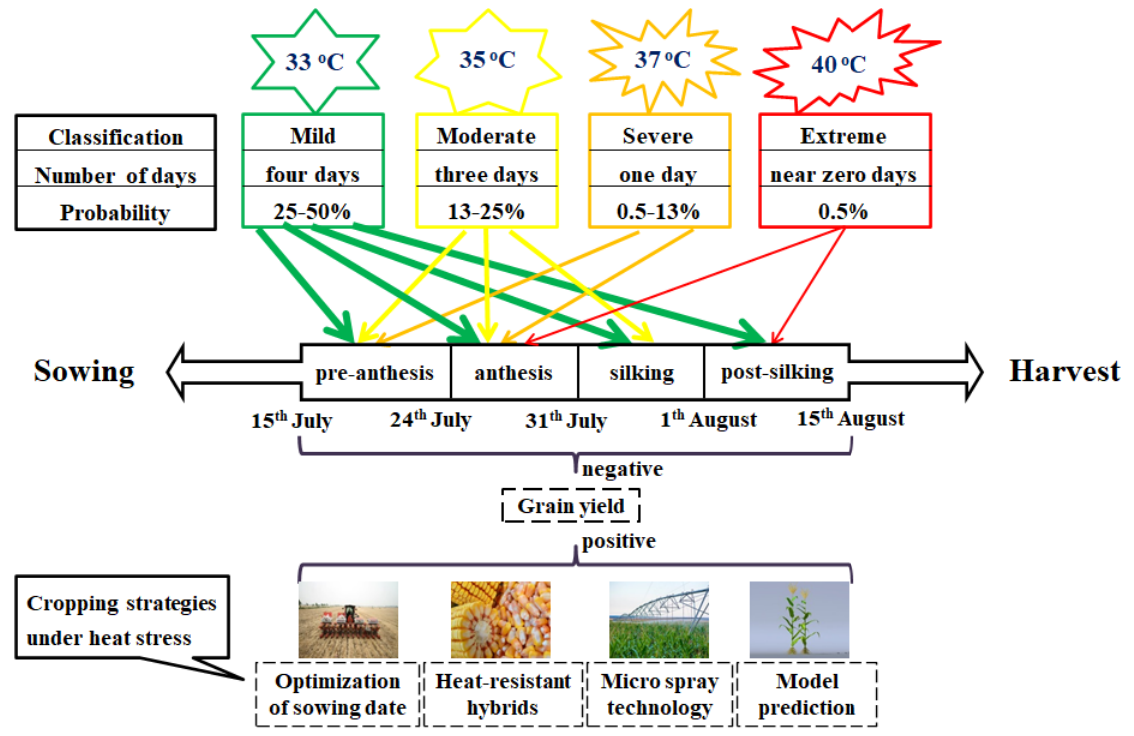
Figure 7. Schematic diagram of occurrence patterns, characteristics, and coping strategies of heat stress in relation to maize cropping on Huaibei Plain, China or similar climate and cropping regions. Note: green, yellow, orange, and red arrow symbols represent mild, moderate, severe, and extreme heat stress, respectively. The thickness and direction of the arrow symbols indicate the probability and phases of the occurrence of heat stress.